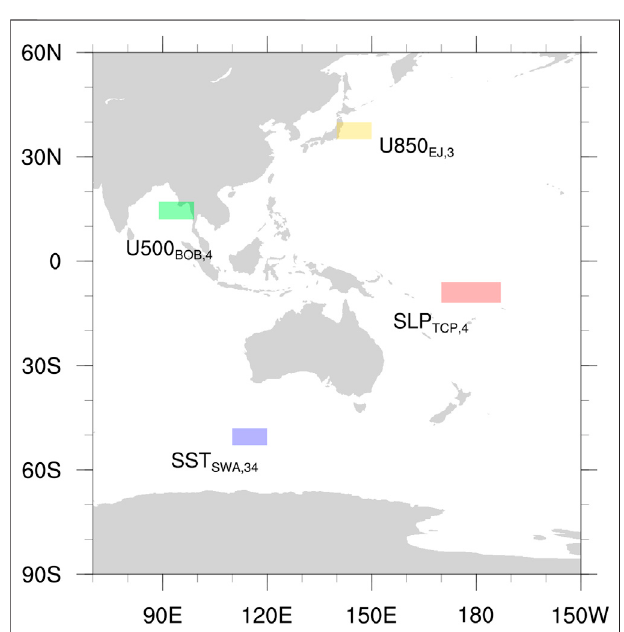
FIGURE 2 | Model predictors. The shaded boxes denote their corresponding